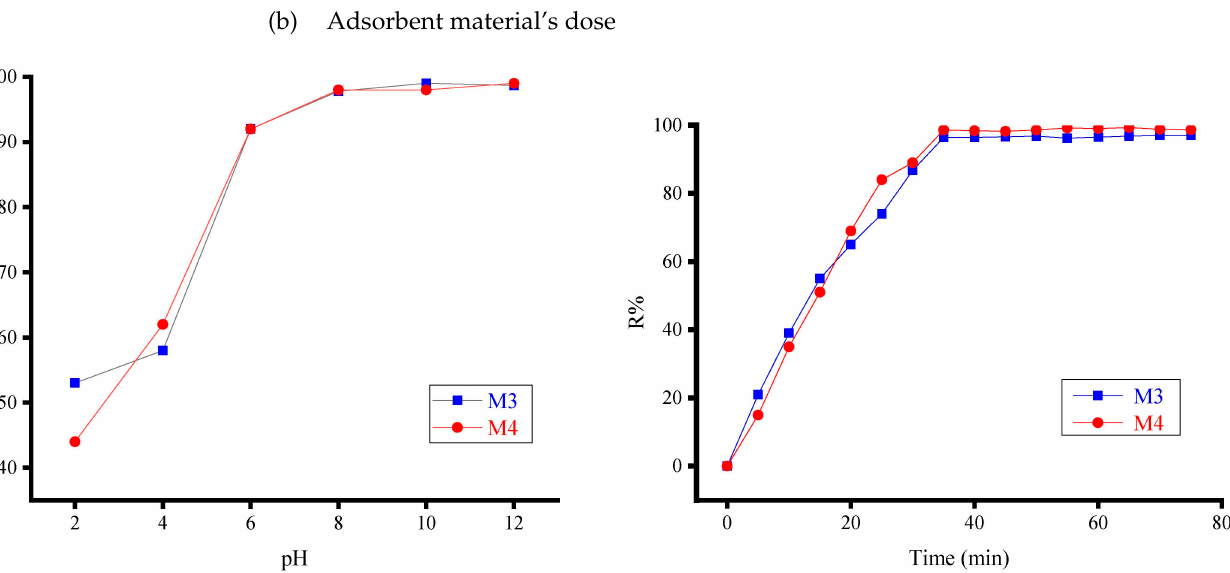
Figure 11. E ff ect of pH and contact time on the adsorption of M3 and M4 by the fabricated adsorbent material.